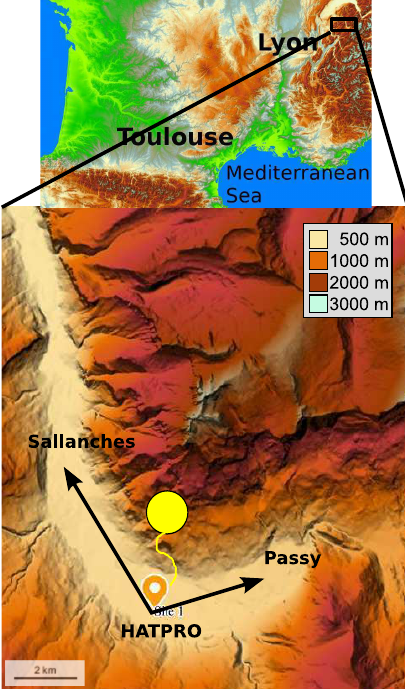
Figure 1. View of the area of interest, close to the city of Passy in the Arve River valley. Microwave radiometer and radiosondes were deployed at measurement site 1. Topographic maps from www.geoportail.gouv.fr (IGN